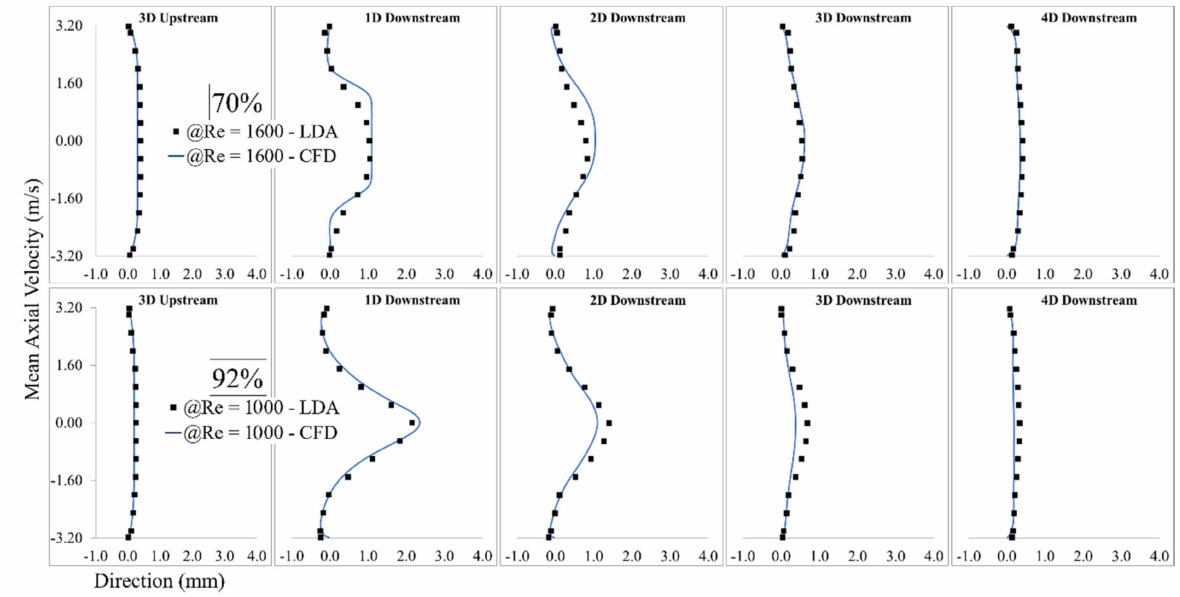
Figure 3. Validation of computational fluid dynamics (CFD) results of 92% stenosis at Re = 1600 with the LDA measurements.